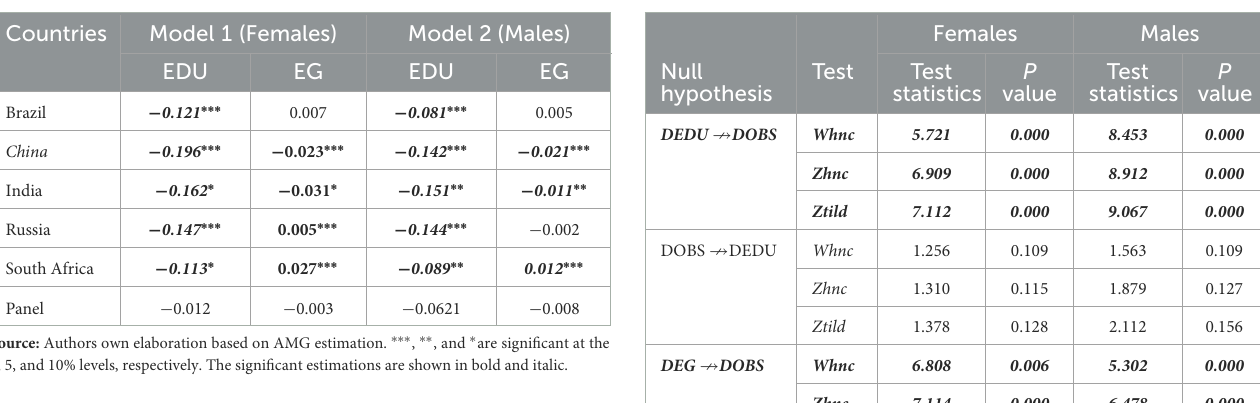
TABLE 8 Real GDP per capita and human development index in BRICS economies. Countries